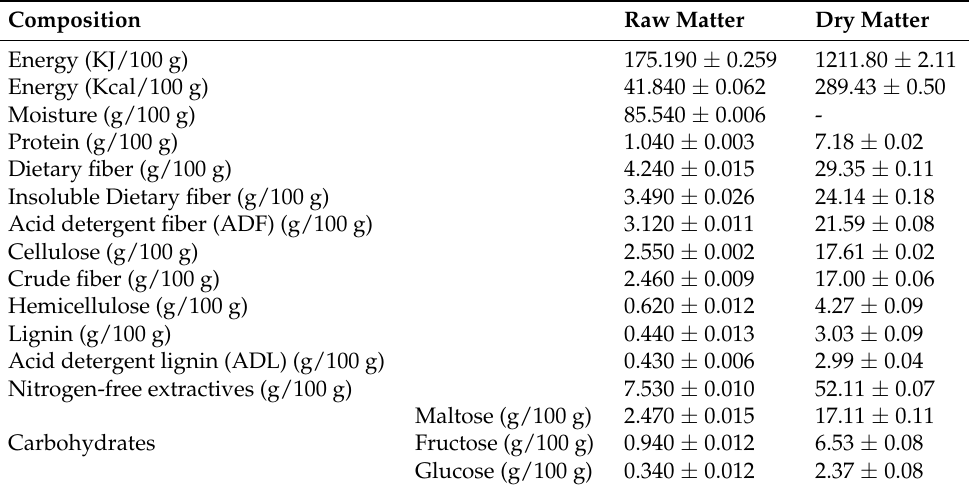
Table 1. Nutritive content of Crepis vesicaria subsp. taraxacifolia leaves (mean ± SD; n = 3).